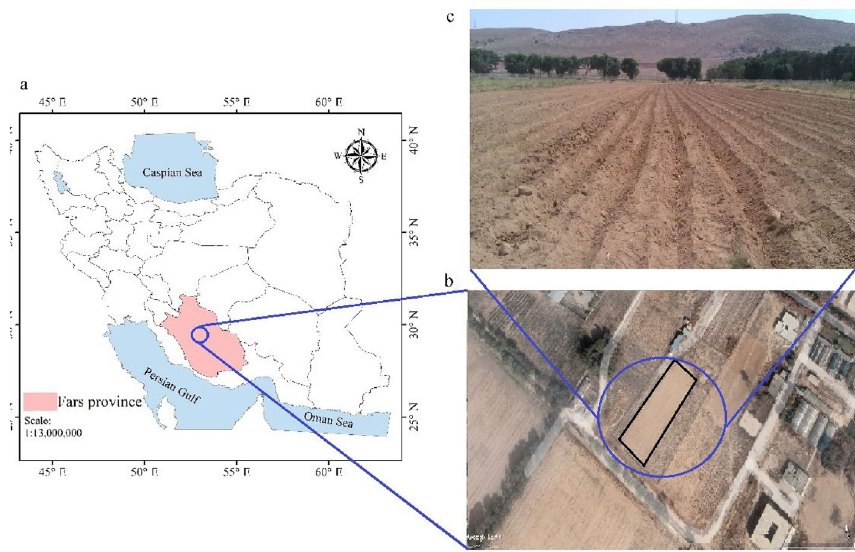
Figure 1. Location of the case study area at the School of Agriculture, Shiraz University, Shiraz, Iran. ( a ) is producd by the open sourse QGIS version 3.24 (www. qgis. org); ( b ) is deveopled using the Google Earth Pro